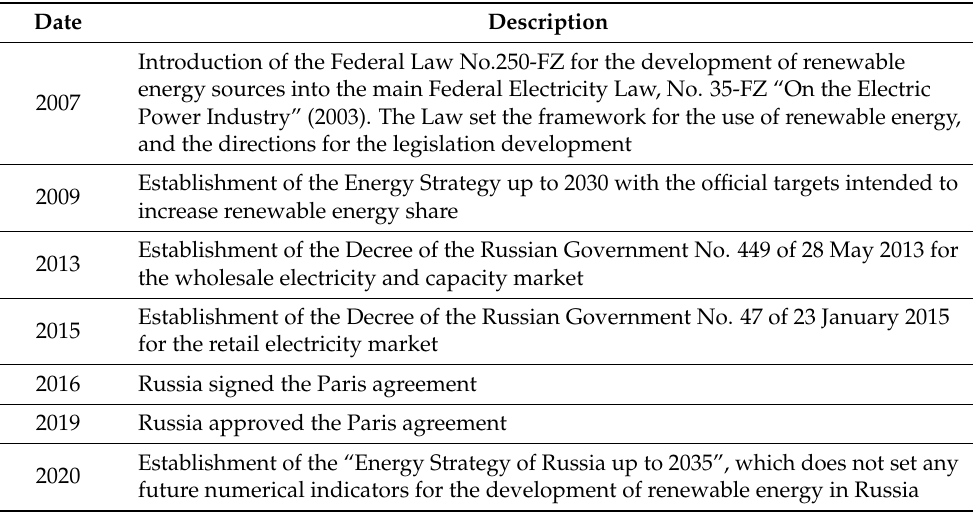
Table 2. The timeline of main regulations in the renewable energy sector of